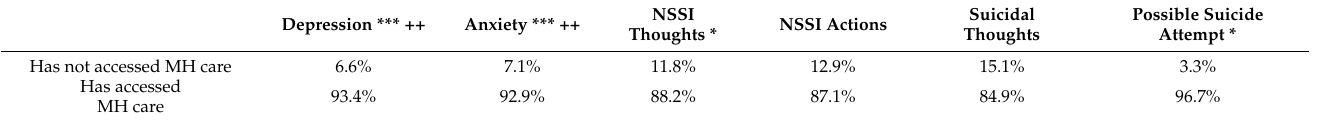
Table 3. Mental health care utilization among students with mental health diagnoses and related experiences 1,2